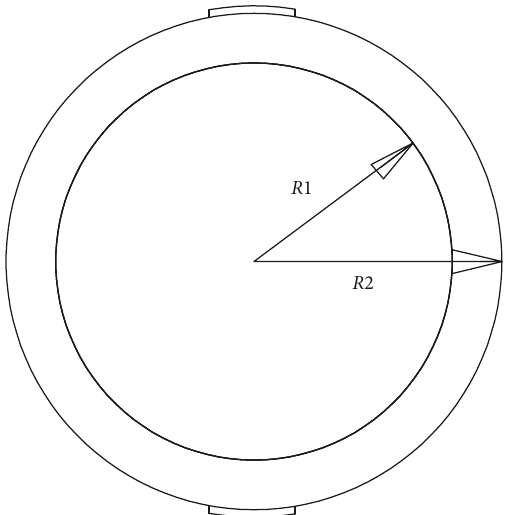
Figure 4: Strain gauge arrangement.